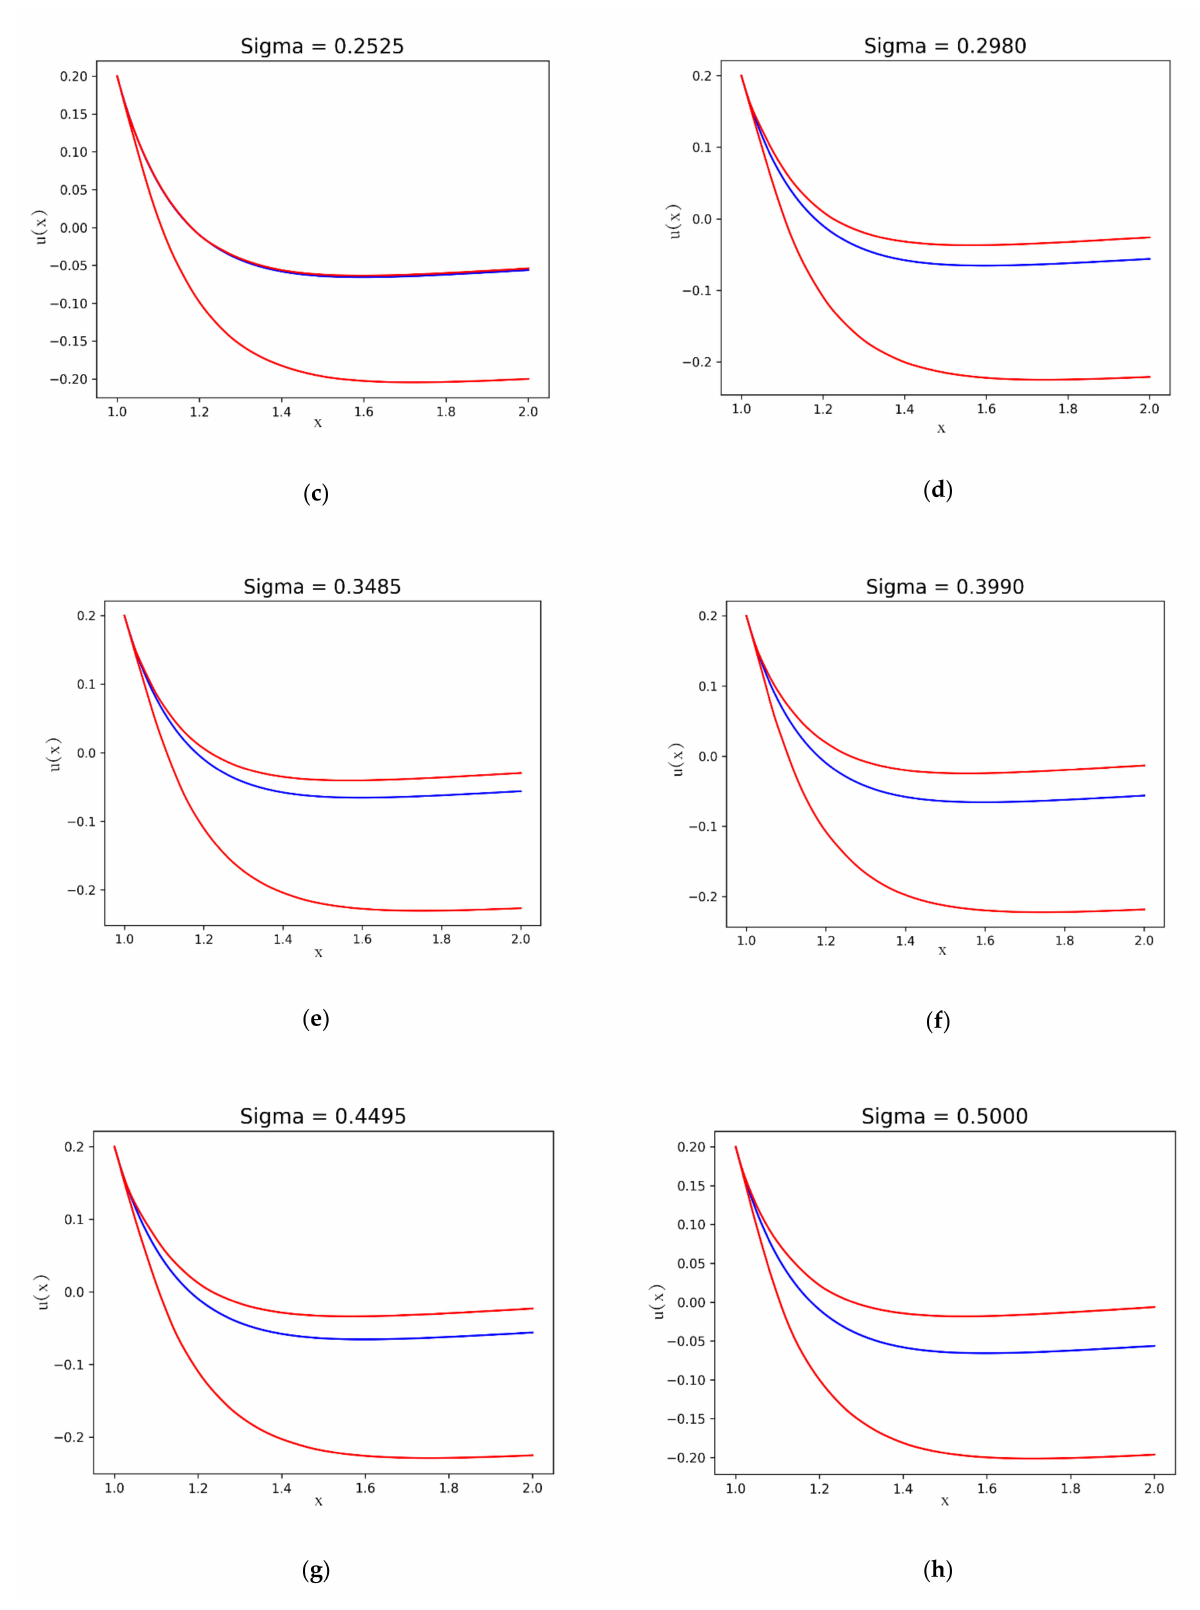
Figure 8. u ( x ) (blue line), U ( x ,100, σ ) (upper red line) and U ( x ,100, σ ) (lower red line) after 200 it- erations for different values of the standard deviation: ( a ) σ = 0; ( b ) σ = 0.1010; ( c ) σ = 0.2525; ( d ) σ = 0.2980; ( e ) σ = 0.3485; ( f ) σ = 0.3990; ( g ) σ = 0.4495; ( h ) σ =